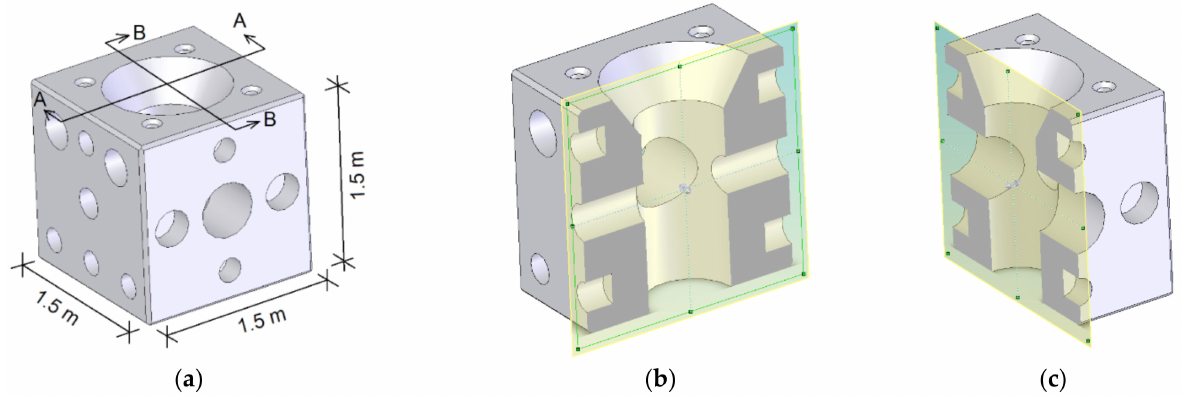
Figure 4. Design of the proposed AR. ( a ) 3D; ( b ) AA section; ( c ) BB